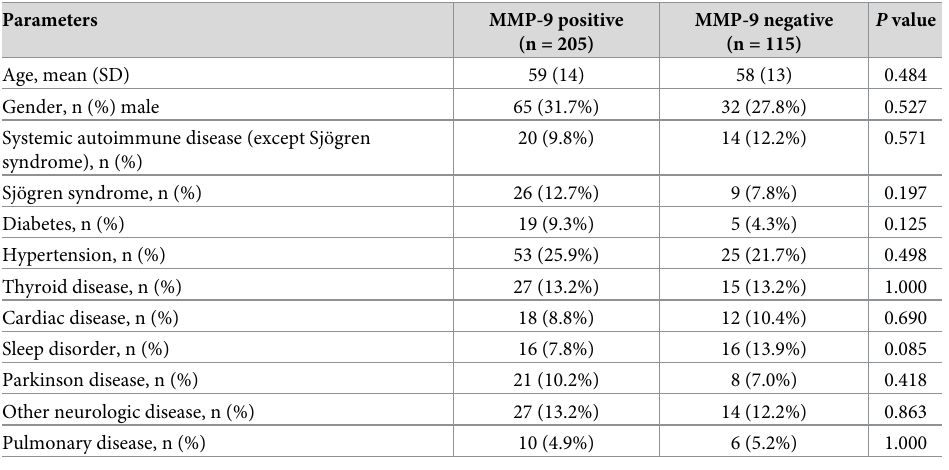
Table 1. Demographics in MMP-9 positive versus negative